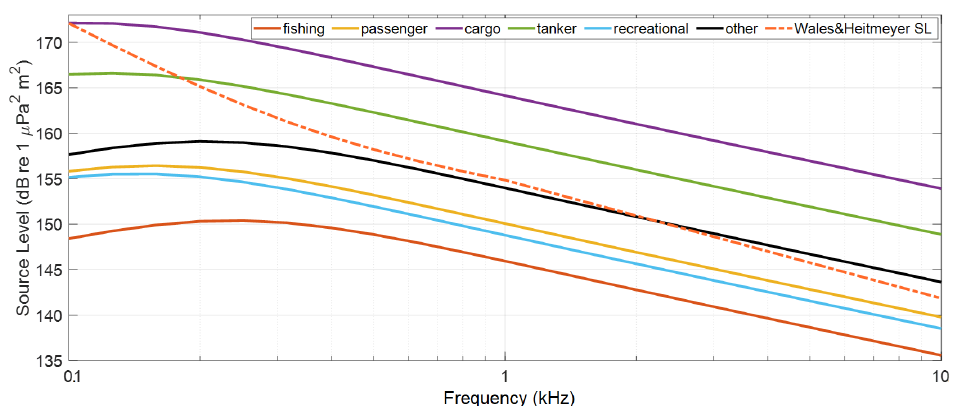
Figure 6. Source level of different ship categories based on the formulas from MacGillivray and de Jong [30] and Wales and Heitmeyer